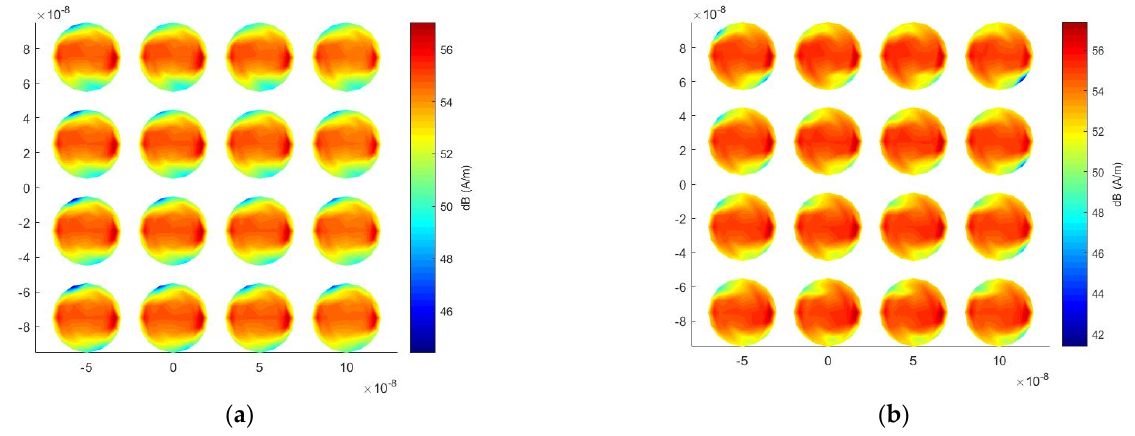
Figure 14. Surface current distribution under different incident angles at 620 nm wavelength for the nano-truncated cone array. ( a ) 120° incident angle; ( b ) 180° incident angle.